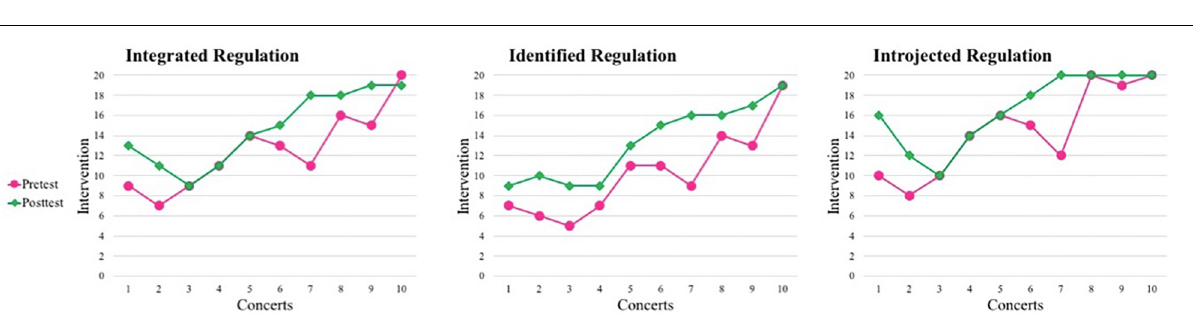
FIGURE 3 | Visual tendency for intrinsic motivation and external regulation. NB: Pretest refers to the piloting of the measures across 5 consecutive practicing days before commencing the intervention; Posttest refers to the period of intervention data collection.